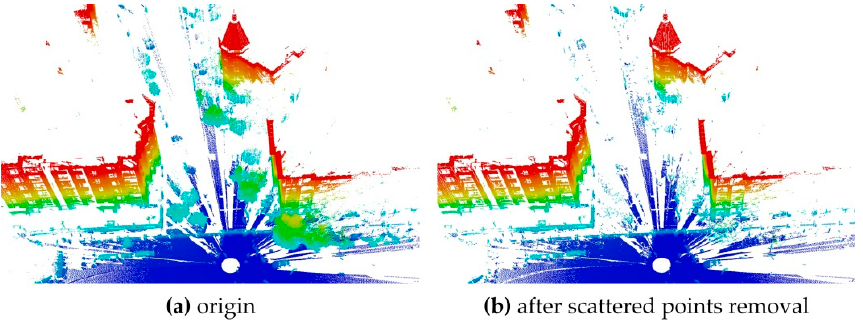
Figure 2. Scattered points removal. The point clouds are rendered by elevation. ( a ) The point cloud before scattered points removal; ( b ) the point cloud after scattered points removal.